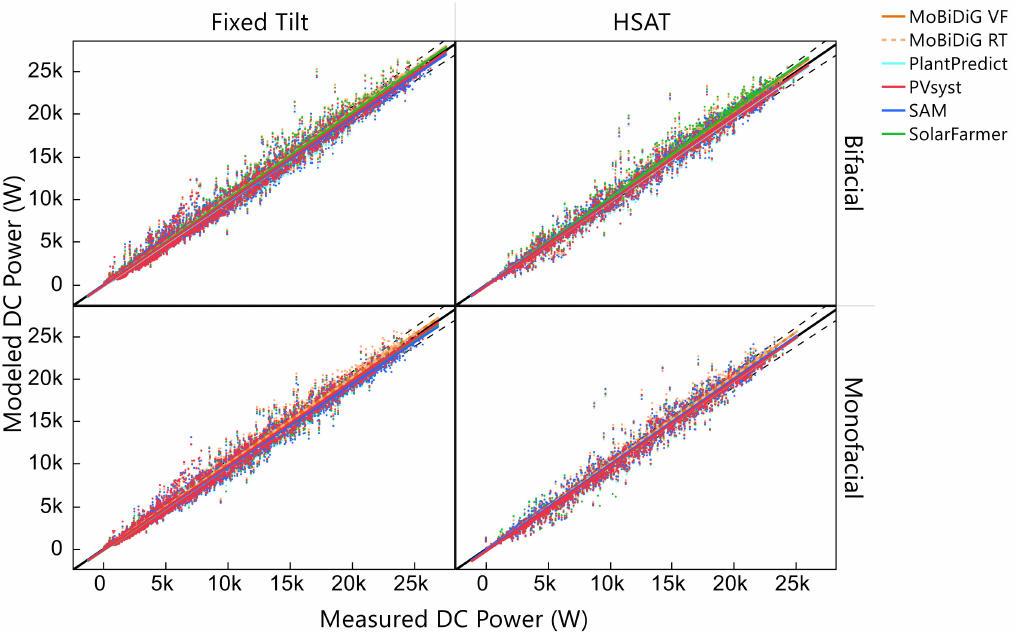
Figure 8. Regressions of hourly modeled versus hourly measured DC power of four the four PV system types studied. Result from six di ff erent software are shown. Data points recorded when the sun elevation was less than 5 ◦ above the horizon were removed from these